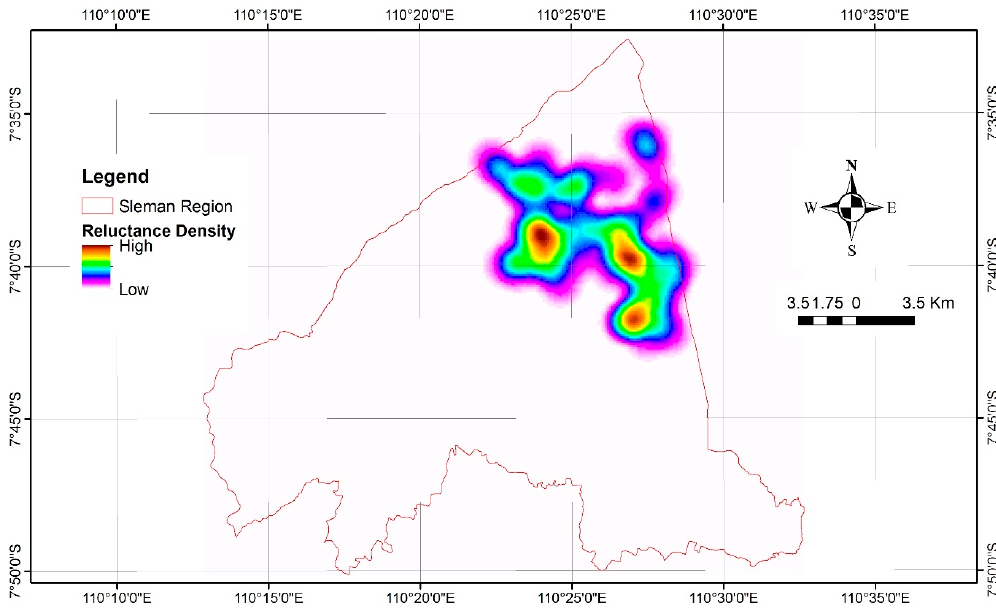
Figure 5. Distribution of reluctant evacuees during the 2010 evacuation (adapted from [12]). The circle shows the 20 km buffer from the summit of the volcano.